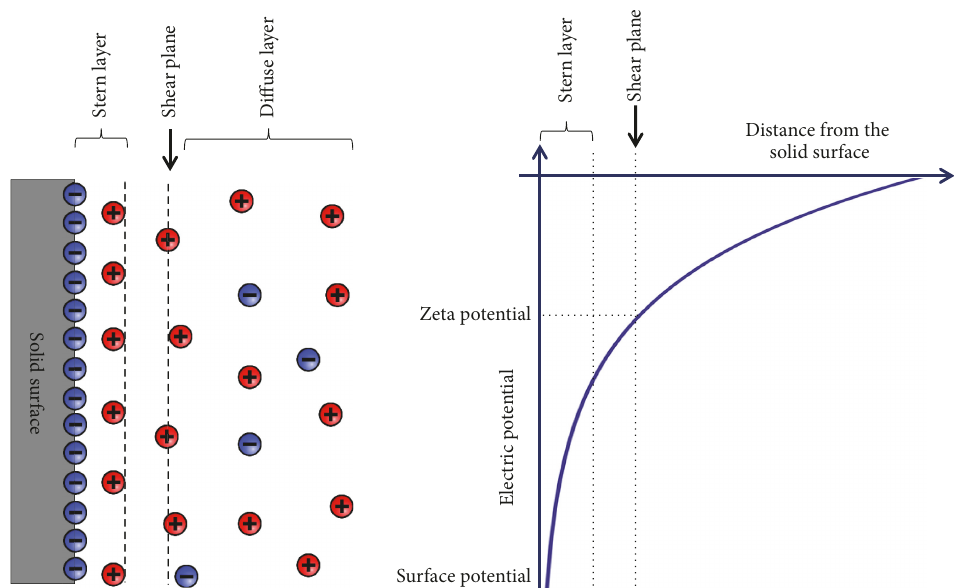
Figure 2: Stern model (see [25–27] for more details) for the charge and electric potential distribution in the electric double layer at a solid- liquid interface. In this figure, the solid surface is negatively charged and the mobile counter-ions in the diffuse layer are positively charged.